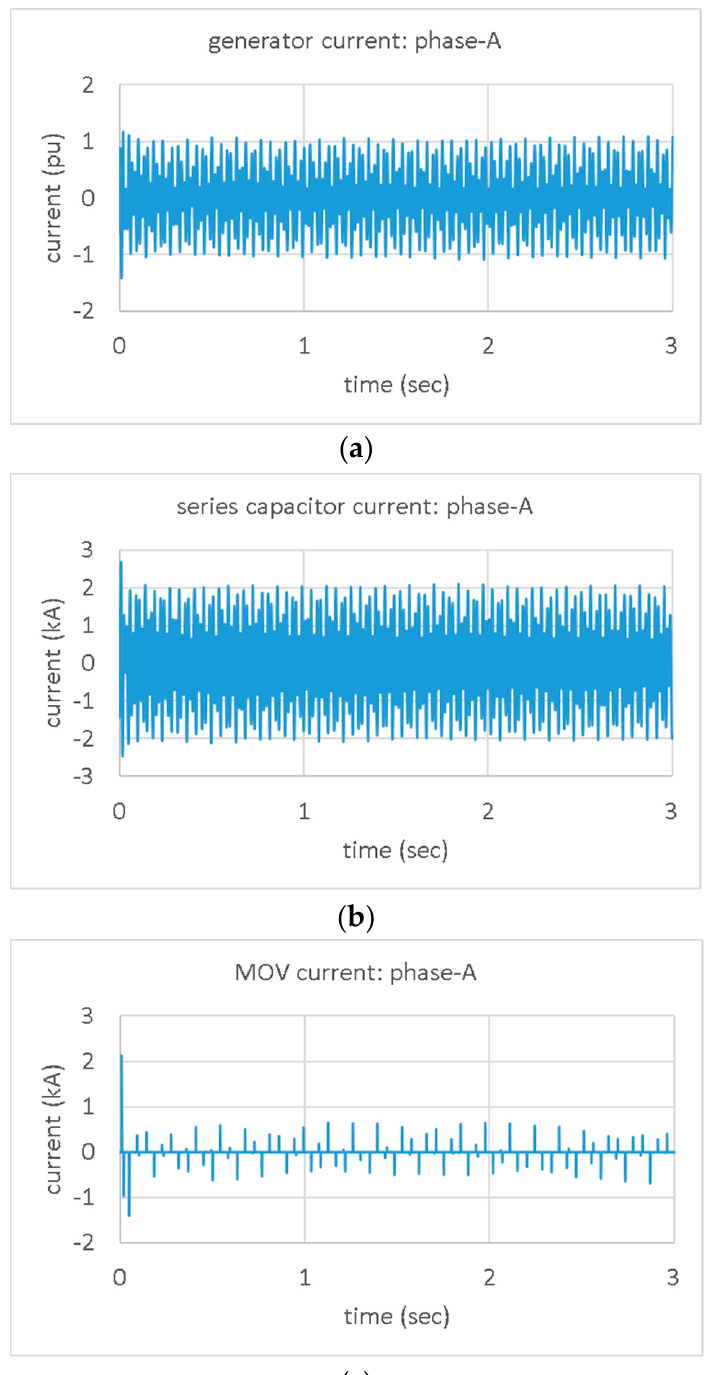
Figure 19. Currents of ( a ) generator, ( b ) capacitor, and ( c ) MOV.